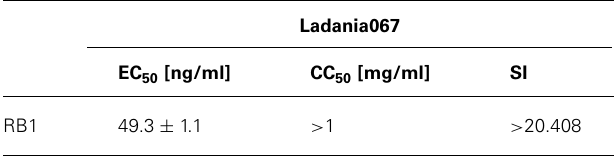
Table 1 | Pharmacological parameters of Ladania067 in vitro a .